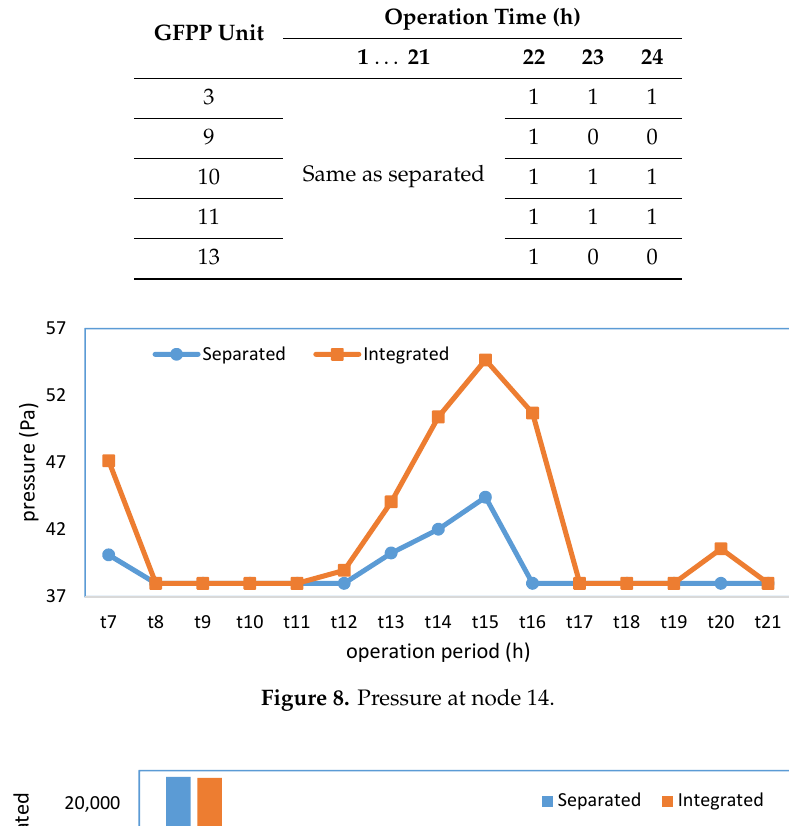
Table 6. Commitment status of GFPPs in integrated method. Figure 8. Pressure at node 14. Table 5. Commitment status of GFPPs in separated method.